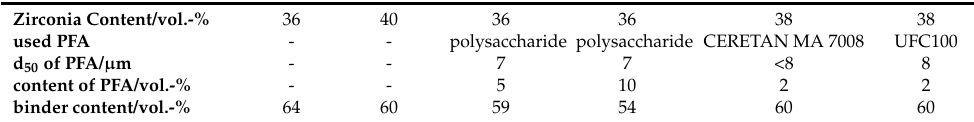
Table 1. Composition of used thermoplastic suspensions. PFA: pore-forming